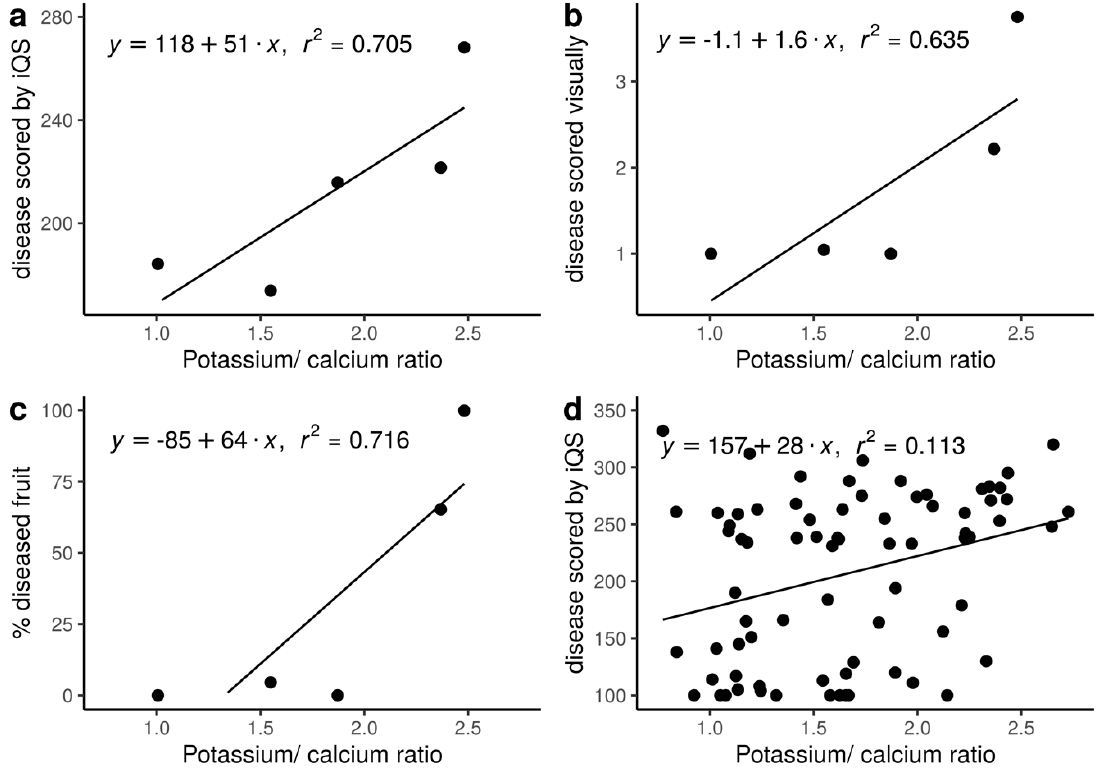
Figure 7. Correlations of K / Ca ratios and disease incidence on fruits. Mean K / Ca ratio as measured on four points across the equator for each fruit by XRF. The mean values per orchard were plotted against soft scald incidence measured using an automatic disorder and disease scoring on a commercial grading machine ( a ), plotted against superficial scald incidence scored visually by eye on a scale from 1 to 5 ( b ), plotted against percent of symptomatic fruits with superficial scald ( c ), and plotted for each single data point using the iQS quality values ( d ). When grouped by means, a high correlation coe ffi cient (0.635 to 0.716) could be measured, whereas plotting all single data points showed a low correlation coe ffi cient, indicating a high variability among the single fruits.